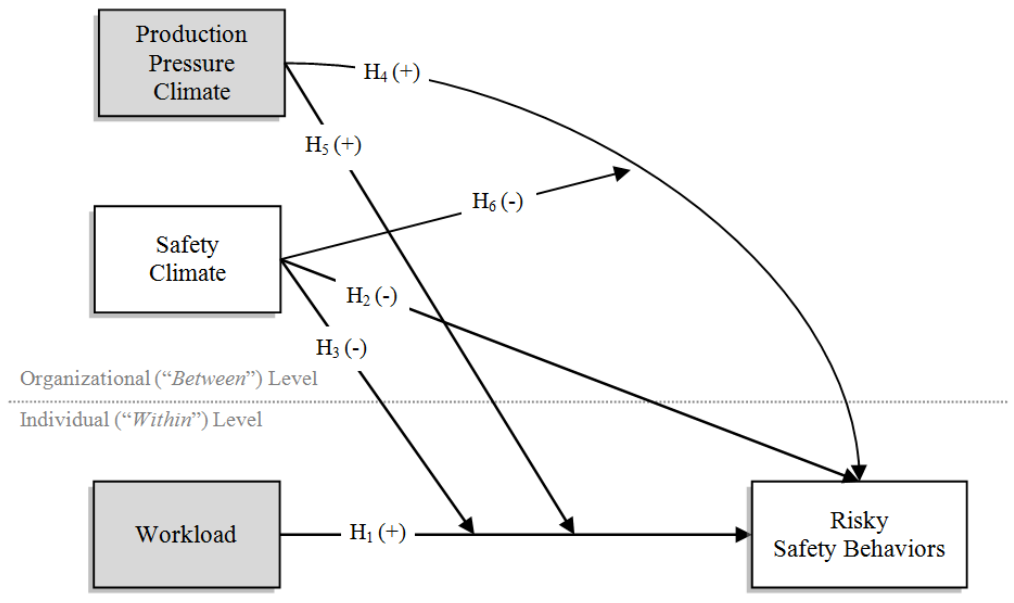
Figure 1. The Overarching Conceptual Model.